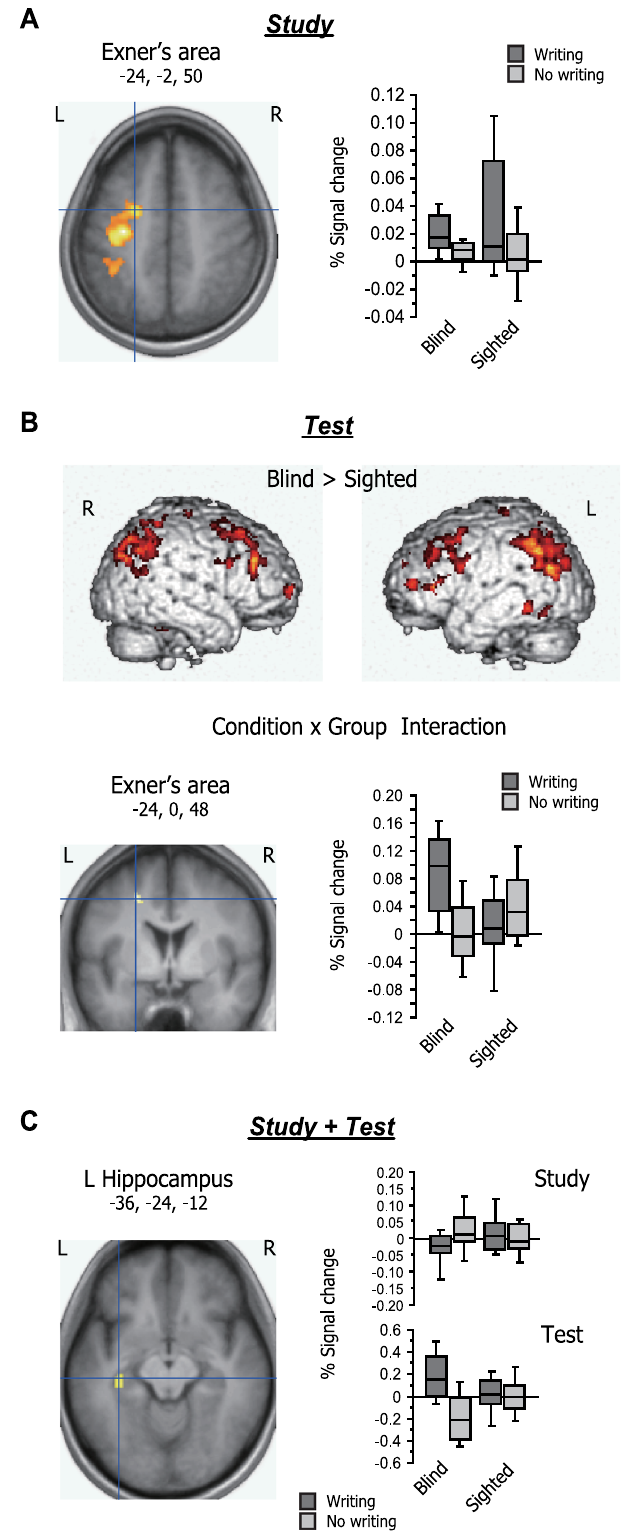
Fig. 3 GLM results. A Neural effects of learning condition and group during the study period. The main effect of condition calculated in the writing vs. no-writing contrast was observed in the right cerebellum (30, -50, − 26, Z = 4.88) and the left sensorimotor cortex ( − 32, − 18, 50, Z = 6.50),